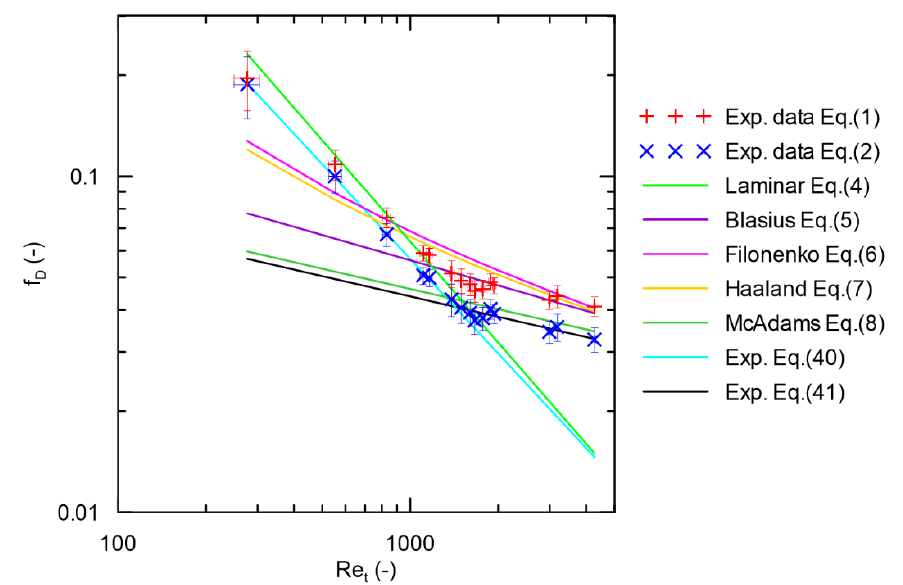
Figure 2. Darcy friction factor 𝑓 (cid:3005) on the tube side flow as a function of the Reynolds number.